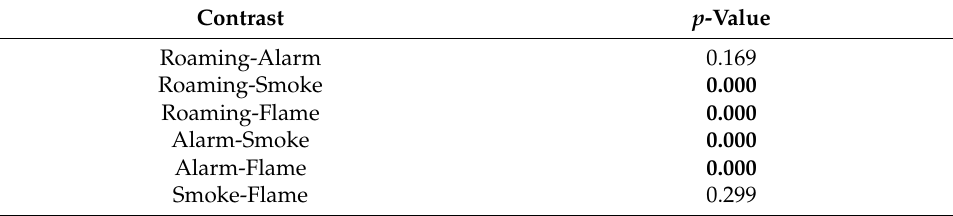
Table 13. p -values of binned entropy of